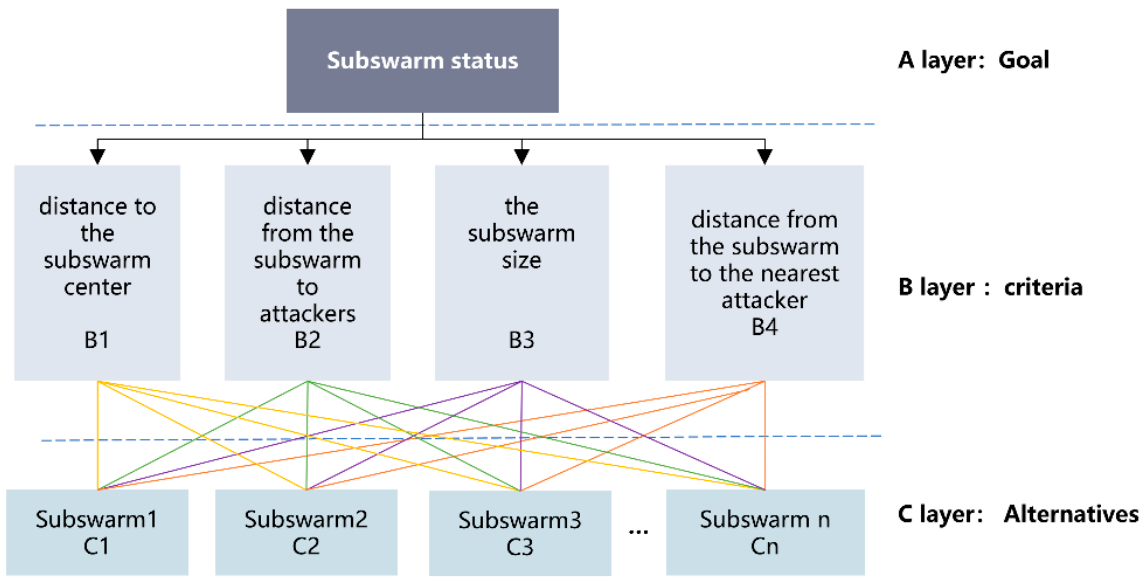
Figure 4. Subswarm status evaluation hierarchy model.